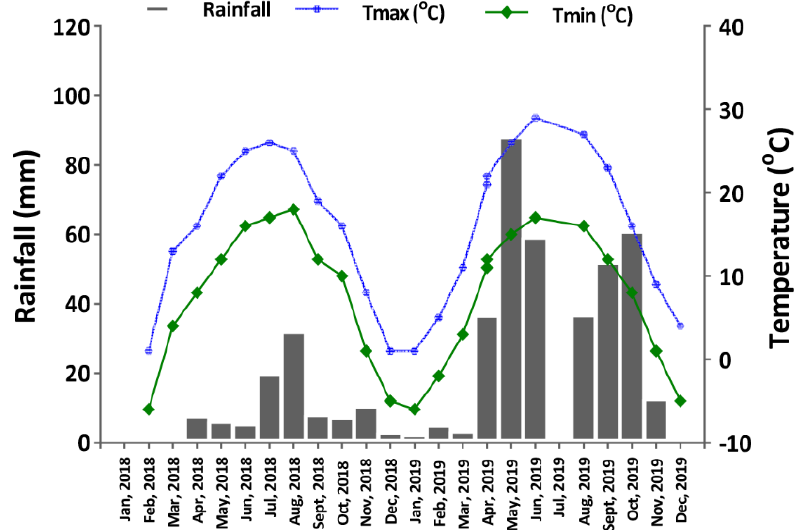
Figure 1. Maximum and minimum temperatures and precipitation at the Yuzhong experimental station (Lanzhou, Gansu, China) from January 2018 to December 2019. The plots were arranged in a randomized complete block design with three